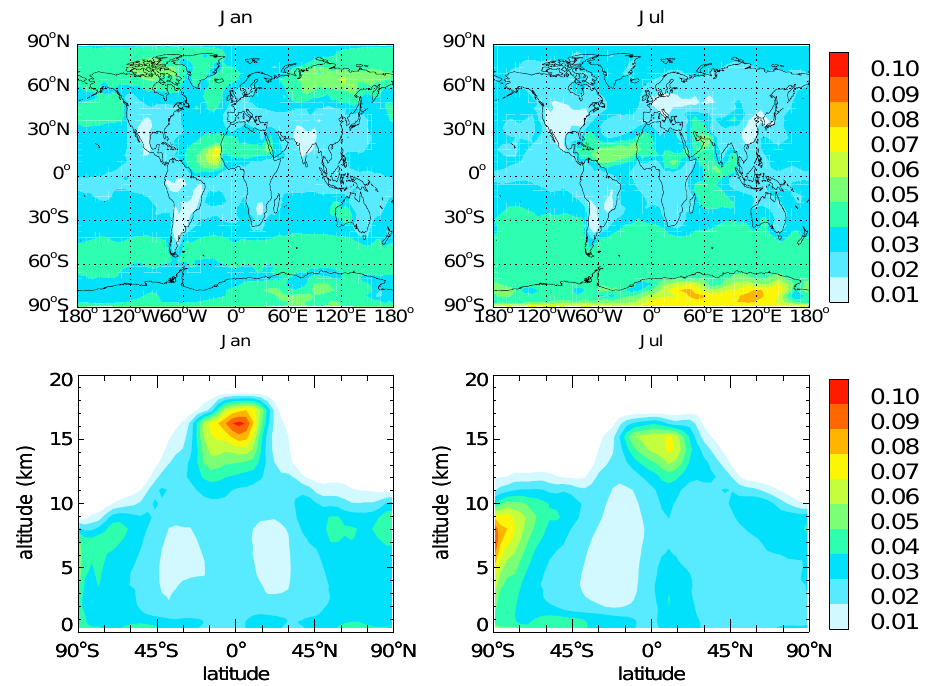
) for January and July as calculated in the model using the parameterisation of 0.2 (Jacob, 2000). The simulation with no H 2 O 2 production is run with γ HO 2